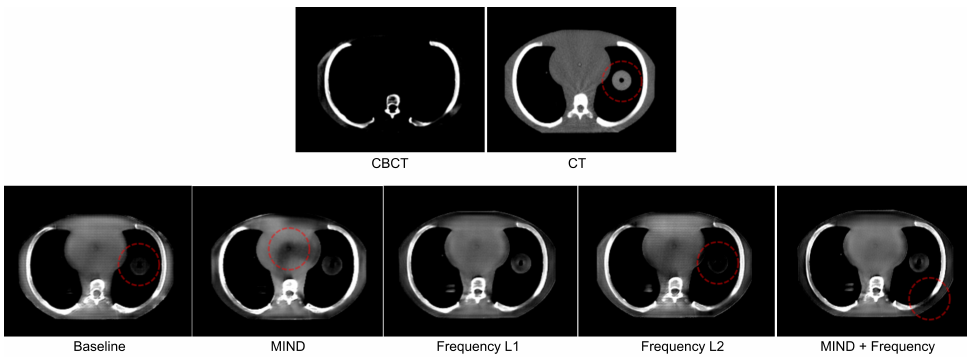
Figure 5. Mid-axial views of the CBCT and CT scans of the phantom shown along with generated images from models with different structure losses. Red dotted circles are used to highlight qualitative observations that are discussed in the